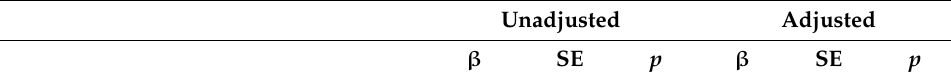
Table 2. Unadjusted and Adjusted Linear Regression Analytic Findings Exploring Associations with FV